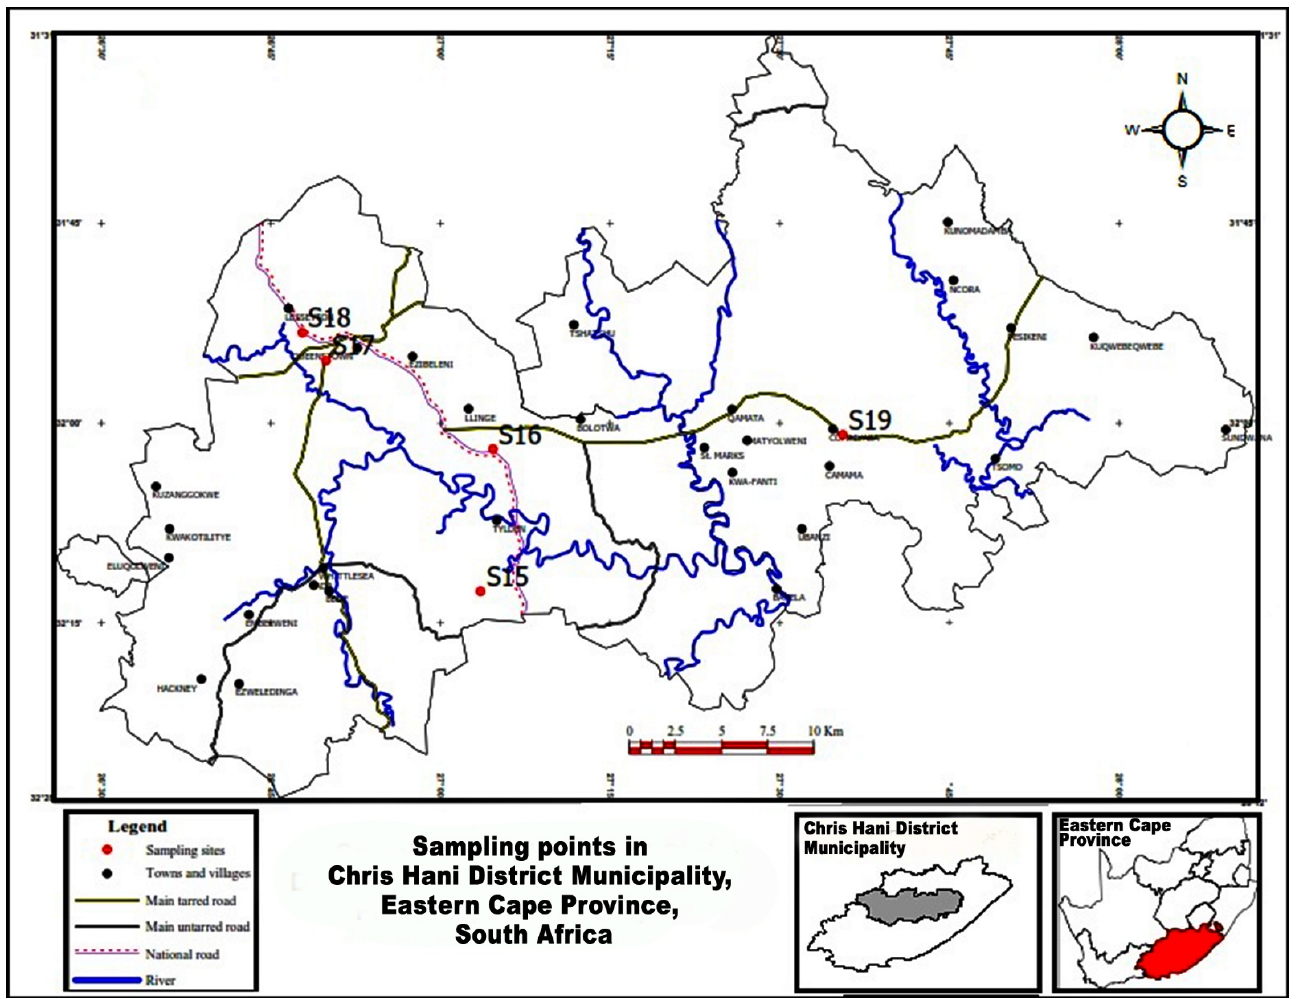
Figure 2. Map showing the sampling sites in Chris Hani District Municipality (grey area), Eastern Cape Province (red area), South Africa. Table 1. Primer sequence, expected amplicon sizes and cycling conditions used in the detection of L. monocytogenes and screening of virulence